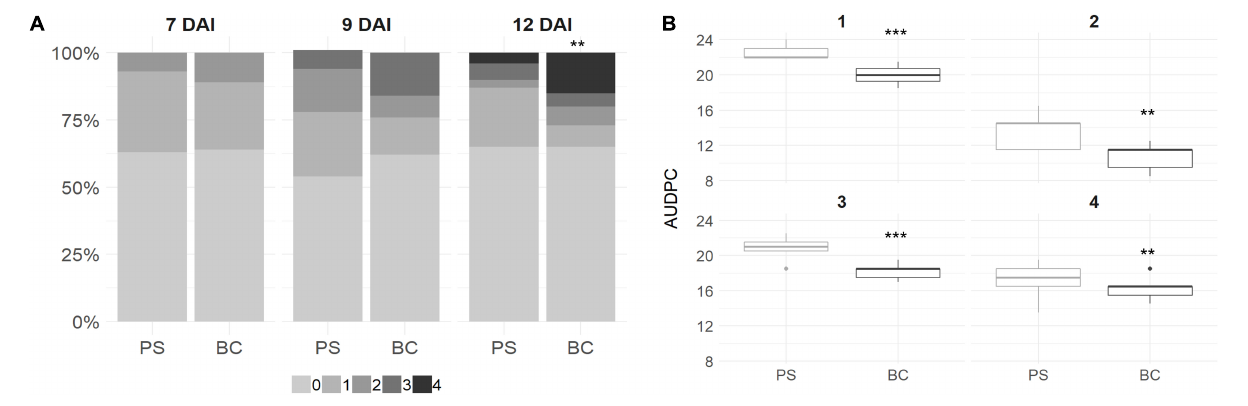
Frontiers in Plant Science |